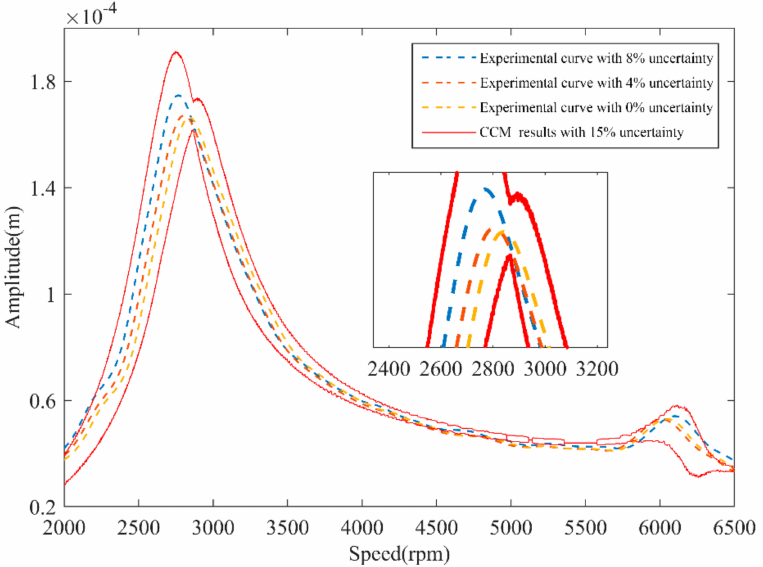
Figure 13. CCM results and experimental results of different uncertainty of dual-disk